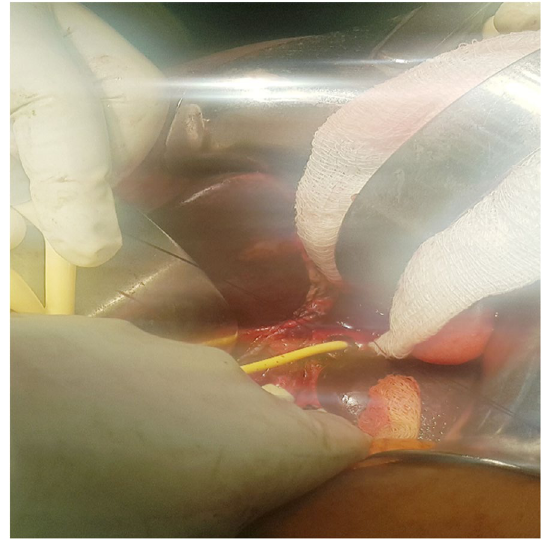
Fig. 3 Mobilized LHD to about 1.5-cm length proximally with dissection partly of liver tissue, Foley catheter introduced for